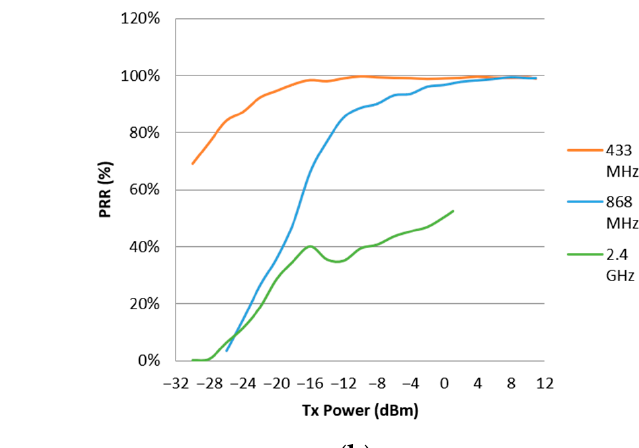
Figure 9. Performance metrics in the cycling scenario: ( a ) Average RSSI, ( b ) PRR.